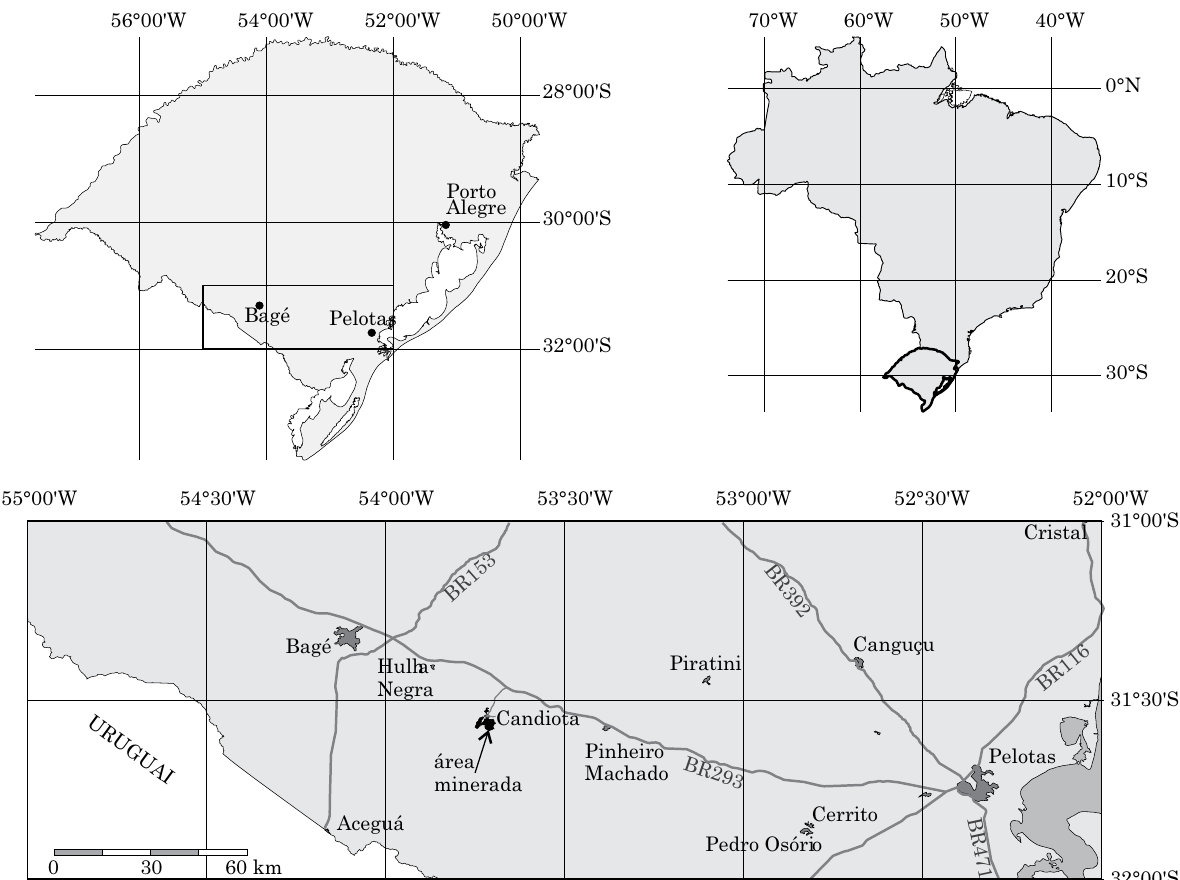
Figura 1. Localização da área de mineração de carvão situada no município de Candiota, no Estado do rio Grande do